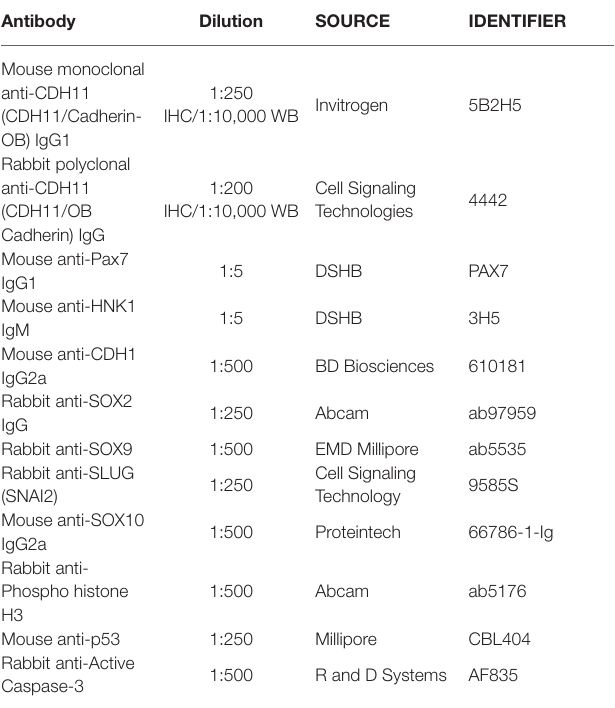
TABLE 1 | Antibodies used in study.